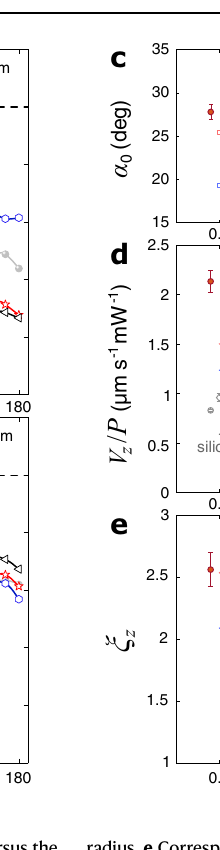
radius. e Corresponding propulsion enhancement factors. Simulated V JP, z were scaled down by the factors indicated in the legend. Markers and error bars in ( d ) and ( e ), respectively indicate the mean values and the 50% standard deviation ranges obtained for 5 different JPs or 2 – 5 different SPs recorded in each ONF sample with R f measured by